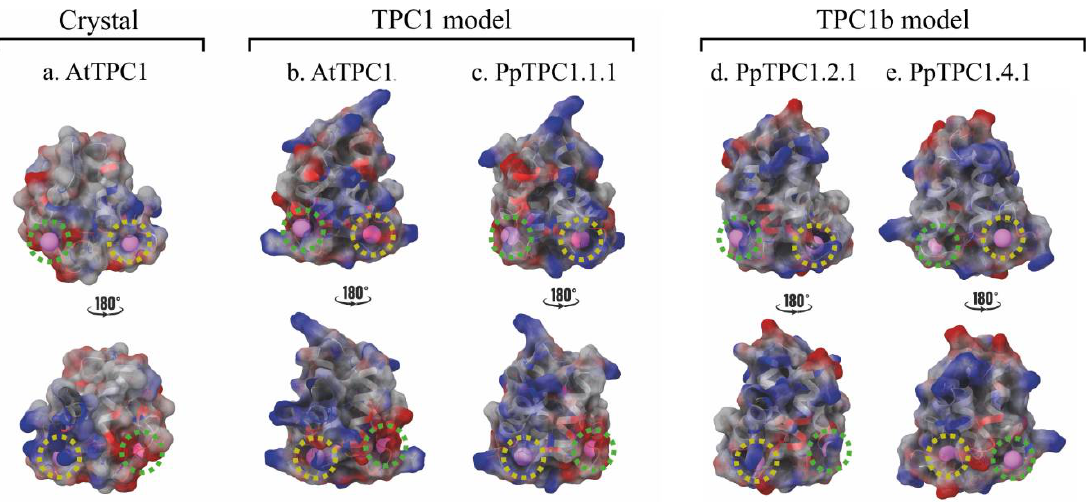
Figure 4. Electrostatic surface of the EF-hands. The electrostatic surface images ( a ) of the AtTPC1 crystal and the models for ( b ) AtTPC1, ( c ) PpTPC1.1.1, ( d ) PpTPC1.2.1, and ( e ) PpTPC1.4.1 are shown in front ( upper panel) and dorsal view ( lower panel). The red regions refer to areas with negatively charged residues; the blue regions refer to areas with positively charged residues; the grey regions refer to hydrophobic areas. The green and yellow dotted circles refer to the Ca 2+ binding sites of the EF1-hand and EF2-hand, respectively.